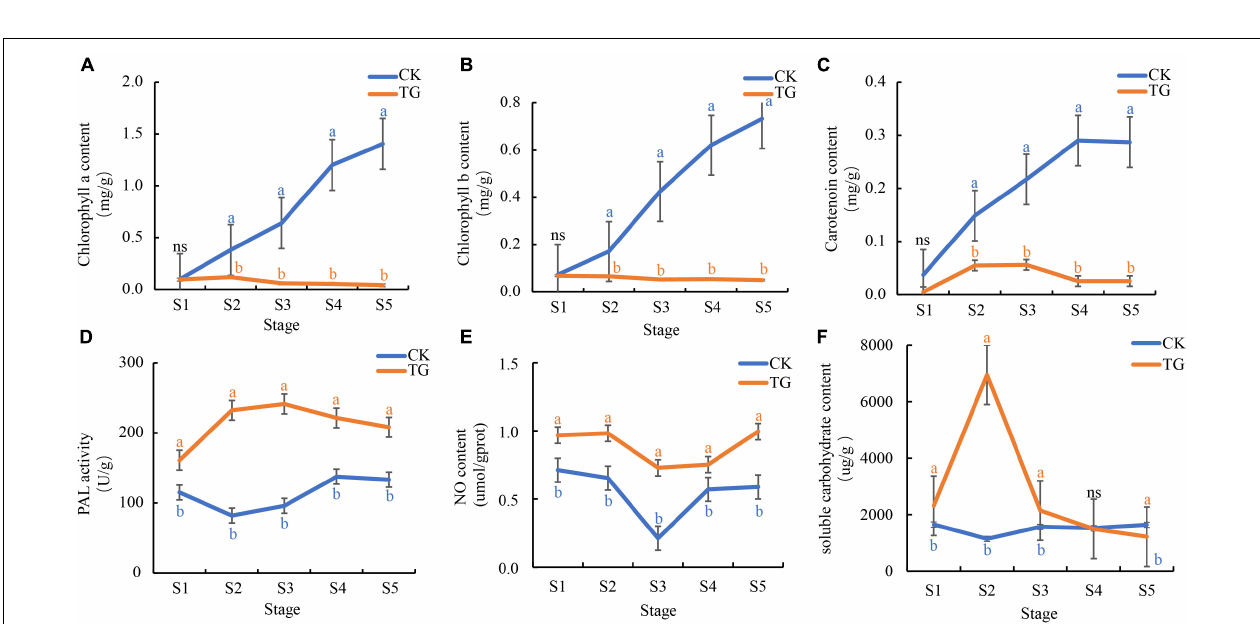
Frontiers in Plant Science |